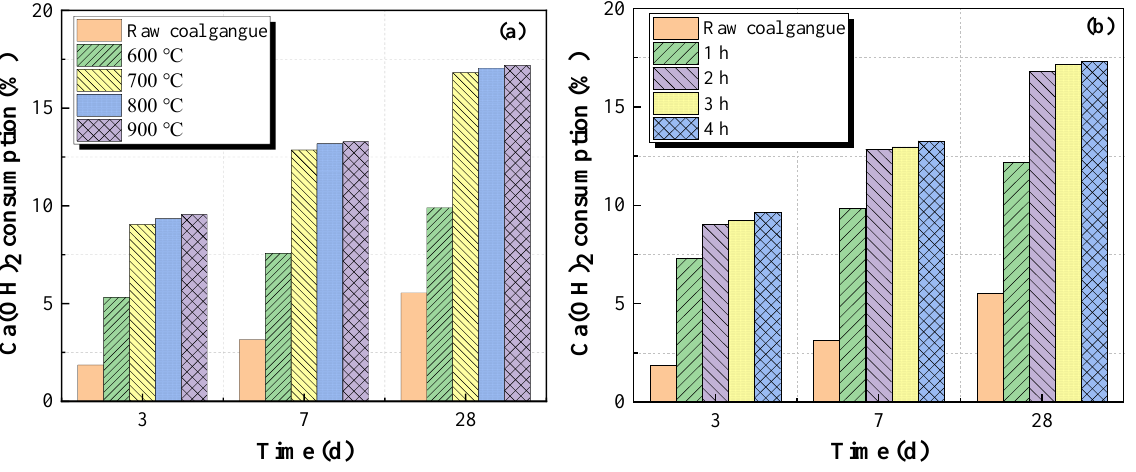
Figure 9. Ca(OH) 2 consumption at different calcination temperatures ( a ) and holding times ( b ). Figure 9 indicates that the Ca(OH) 2 consumption increased with the increase in the calcination temperatures and holding times, indicating that thermal activation can signifi- cantly improve the reactivity of raw coal gangue. However, Ca(OH) 2 consumption is stable when the calcination temperature exceeds 700 ◦ C and the holding time exceeds two hours. The results are consistent with Figure 5. Although further increasing the calcination temper- atures and holding times may increase Ca(OH) 2 consumption, it is also not recom- mended because of the excessive energy costs. Therefore, the optimum calcination tem- perature and holding time are 700 ℃ and two hours, respectively.